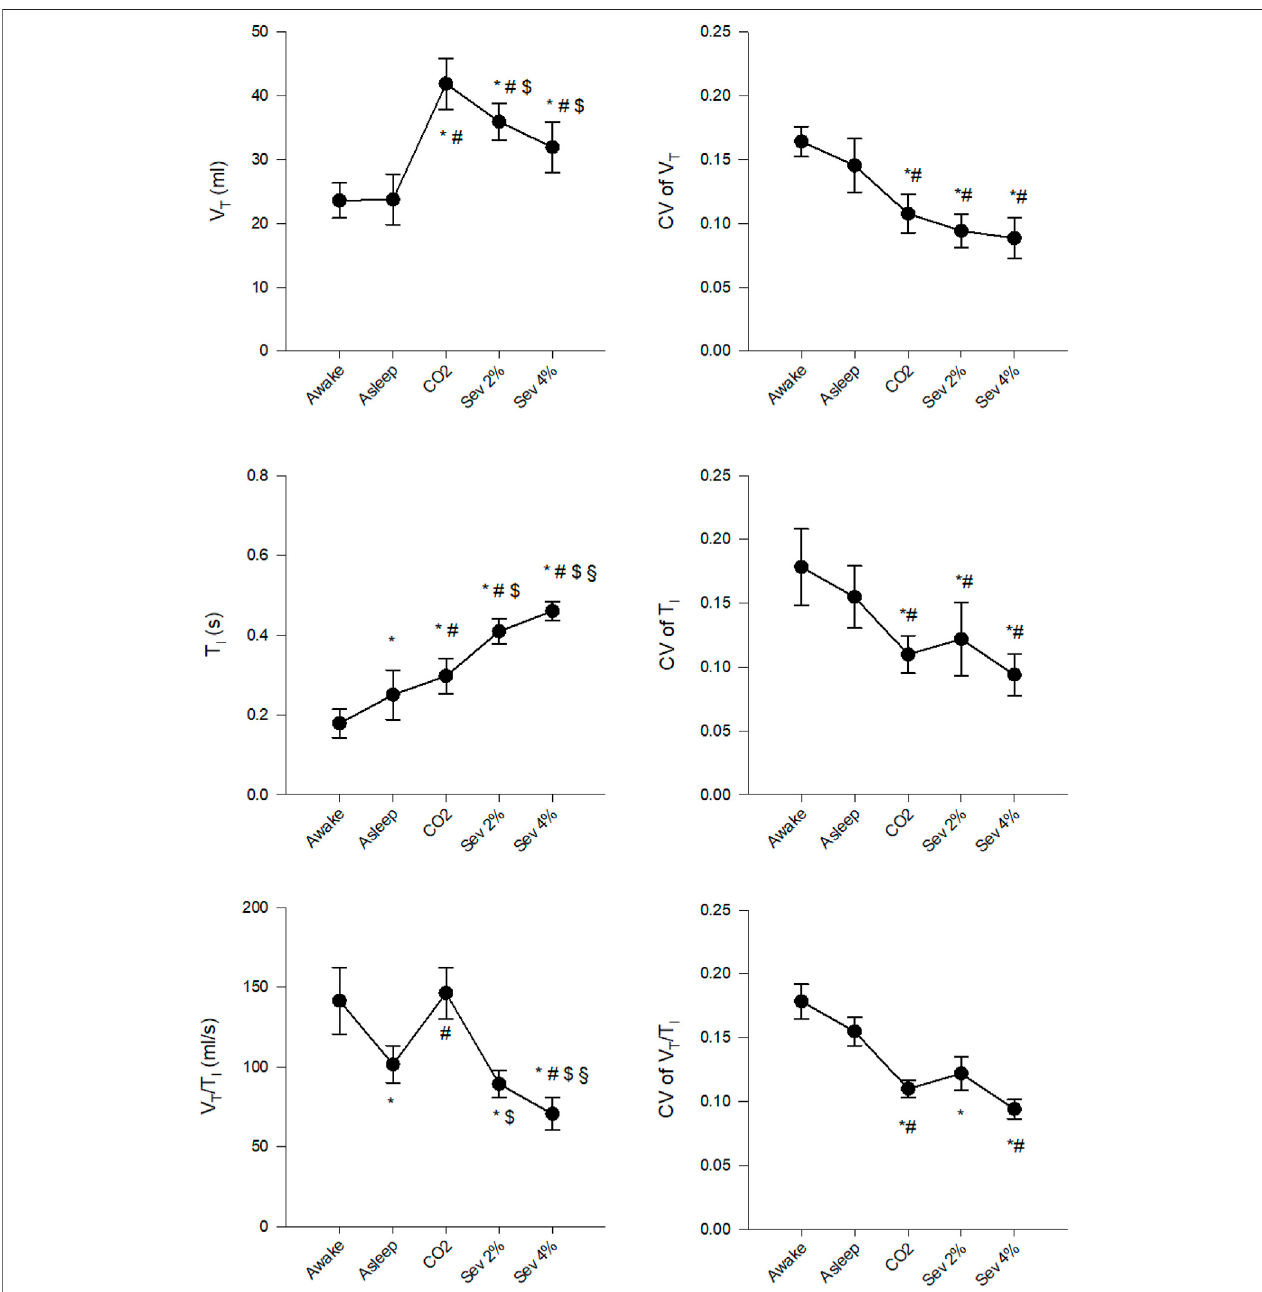
FIGURE 2 | Changes in the absolute values and coef fi cients of variation (CV) of tidal volume (V T ), inspiratory time (T I ) and their ratio (V T /T I ) in wakeful (Awake) and